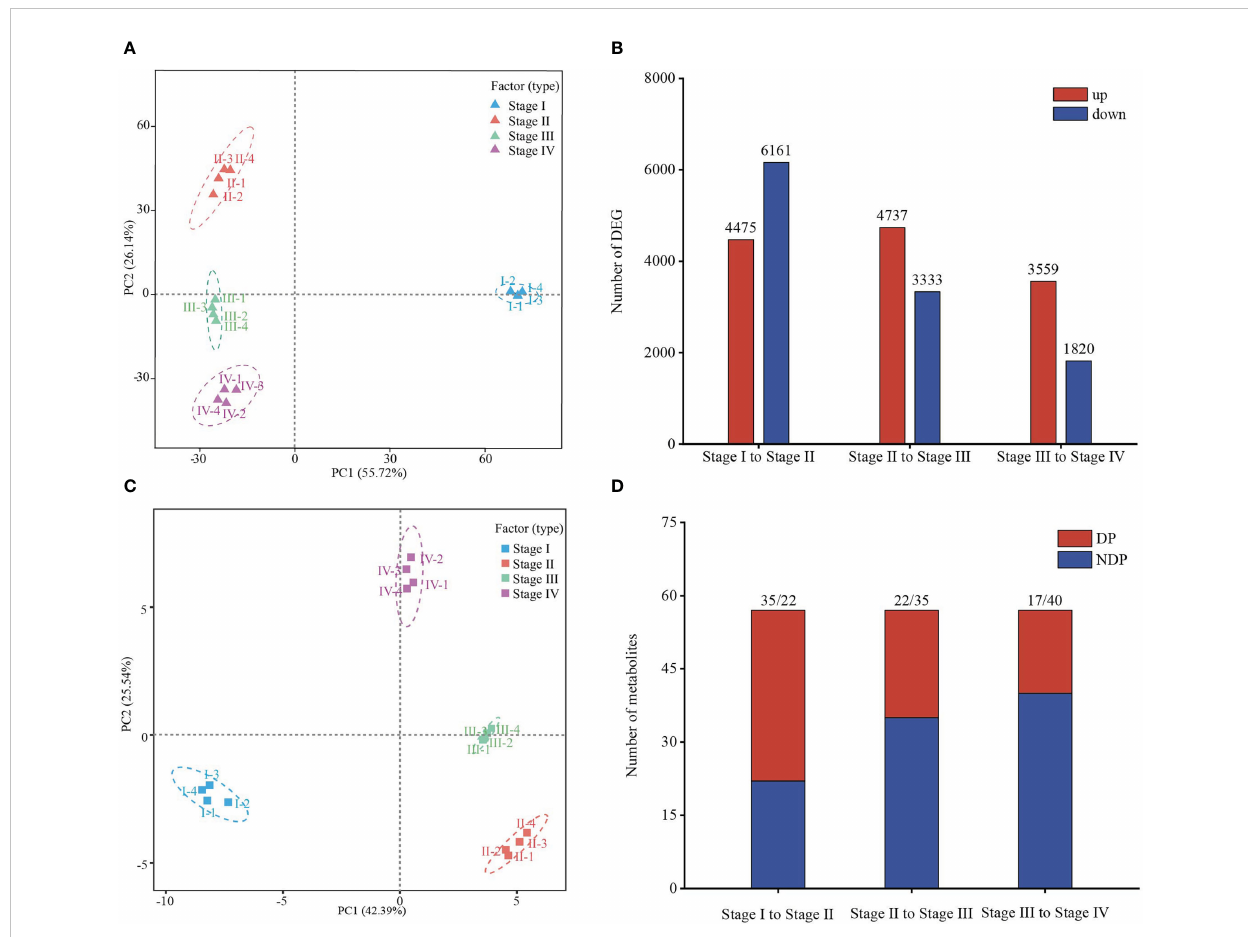
FIGURE 3 Transcriptomic and metabolic analyses reveal a dynamic transition during Zostera marina seed development. (A, C) PCA of transcriptome and metabolome during Zostera marina seed development. (B) Numbers of up- and down- regulated genes at different stages. (D) Number of differential metabolites during the transition between development stages. DP, differential metabolites. NDP, non-differential